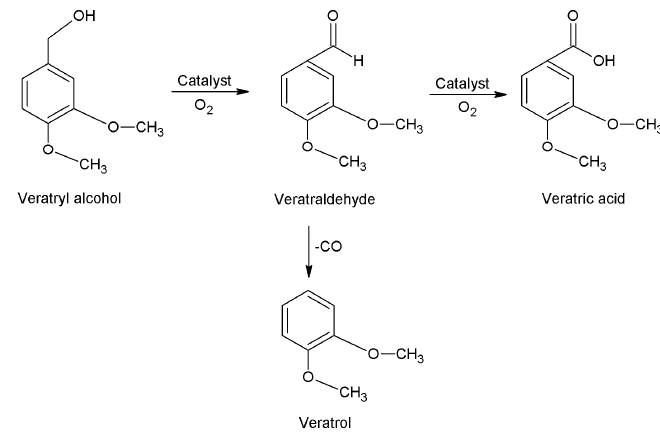
Scheme 1. Reaction pathway of selective oxidation of veratryl alcohol.